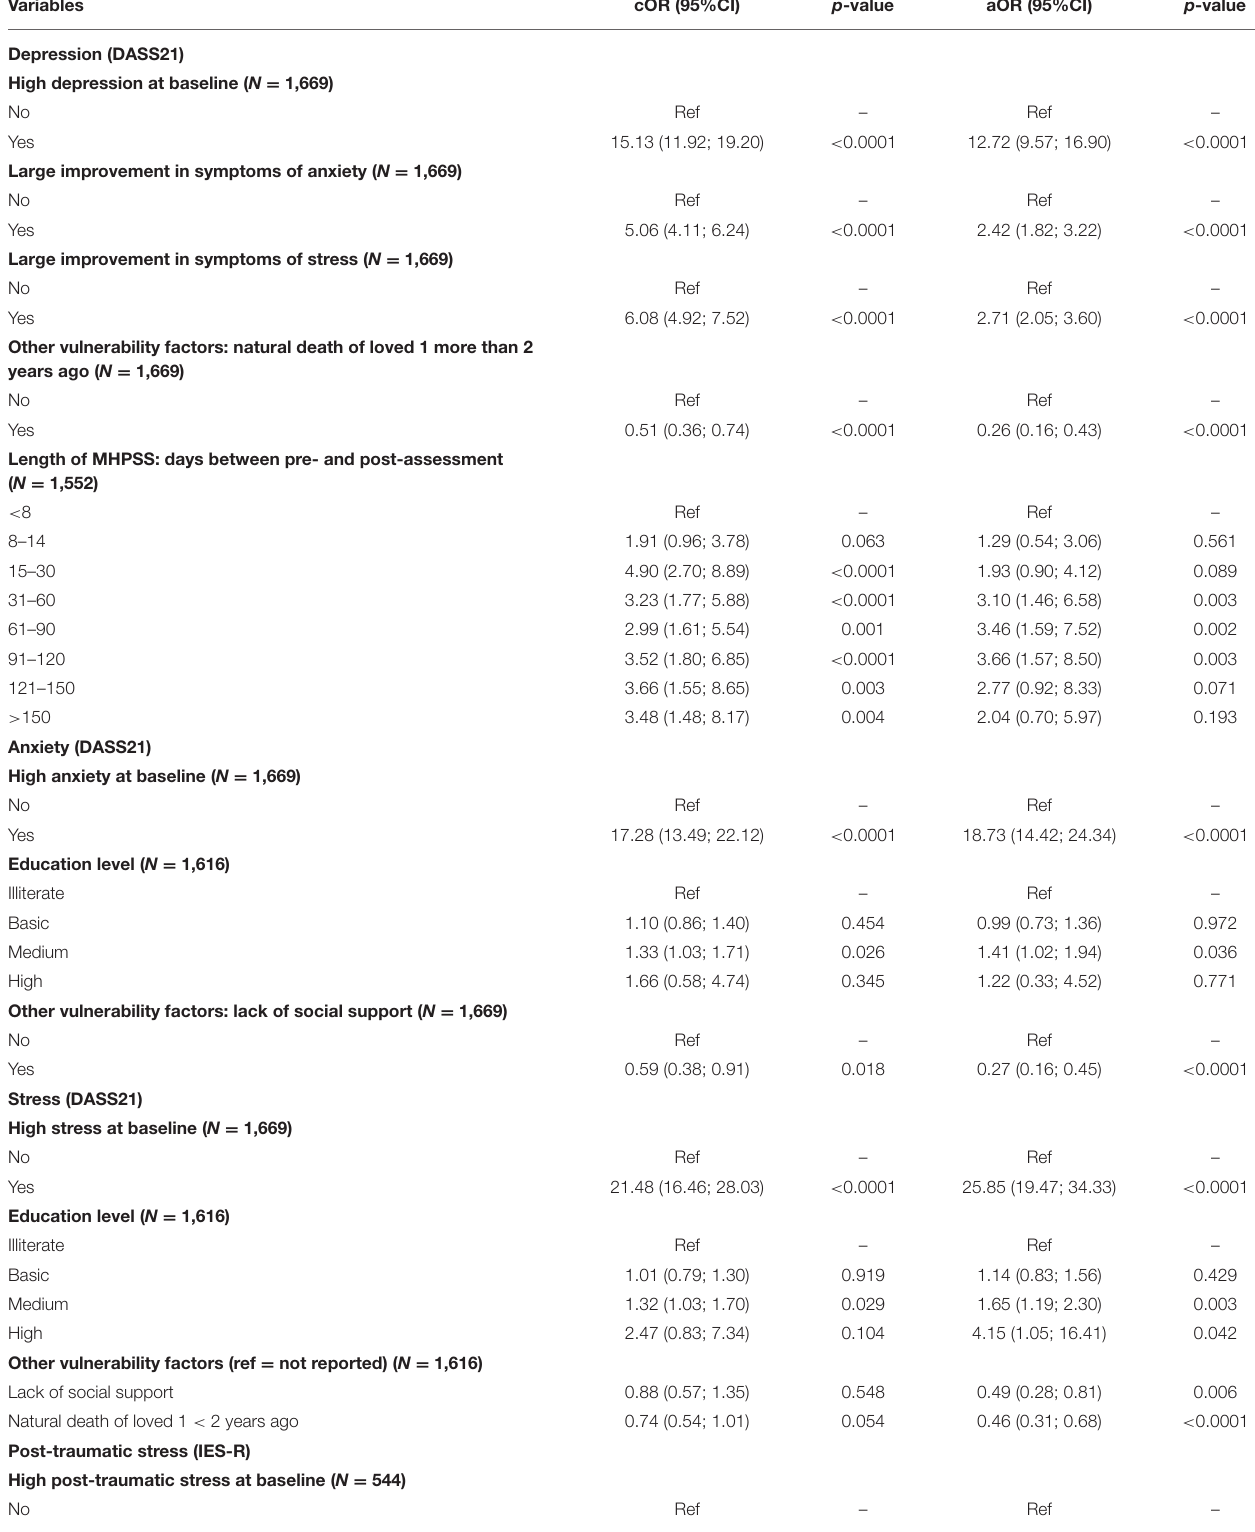
TABLE 5 | Factors associated with improved distress and functioning following MHPSS. Variables Depression